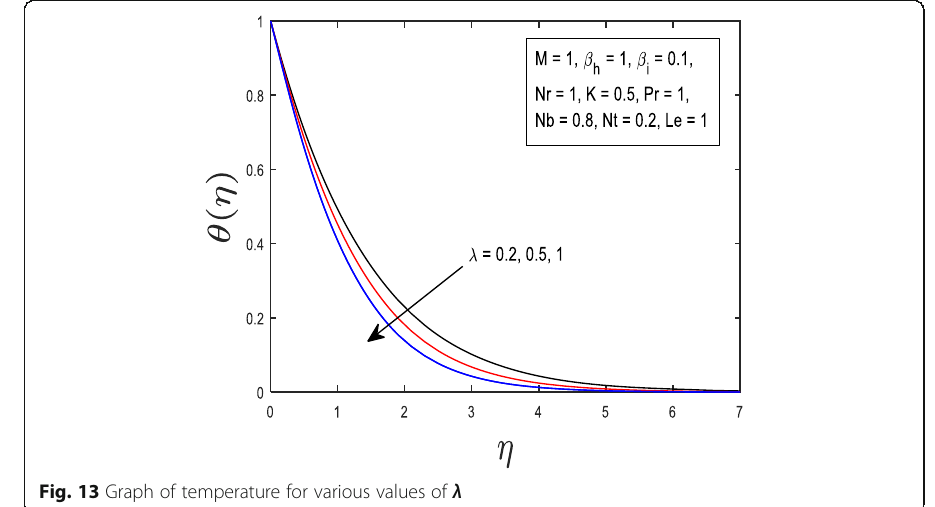
Fig. 13 Graph of temperature for various values of λ